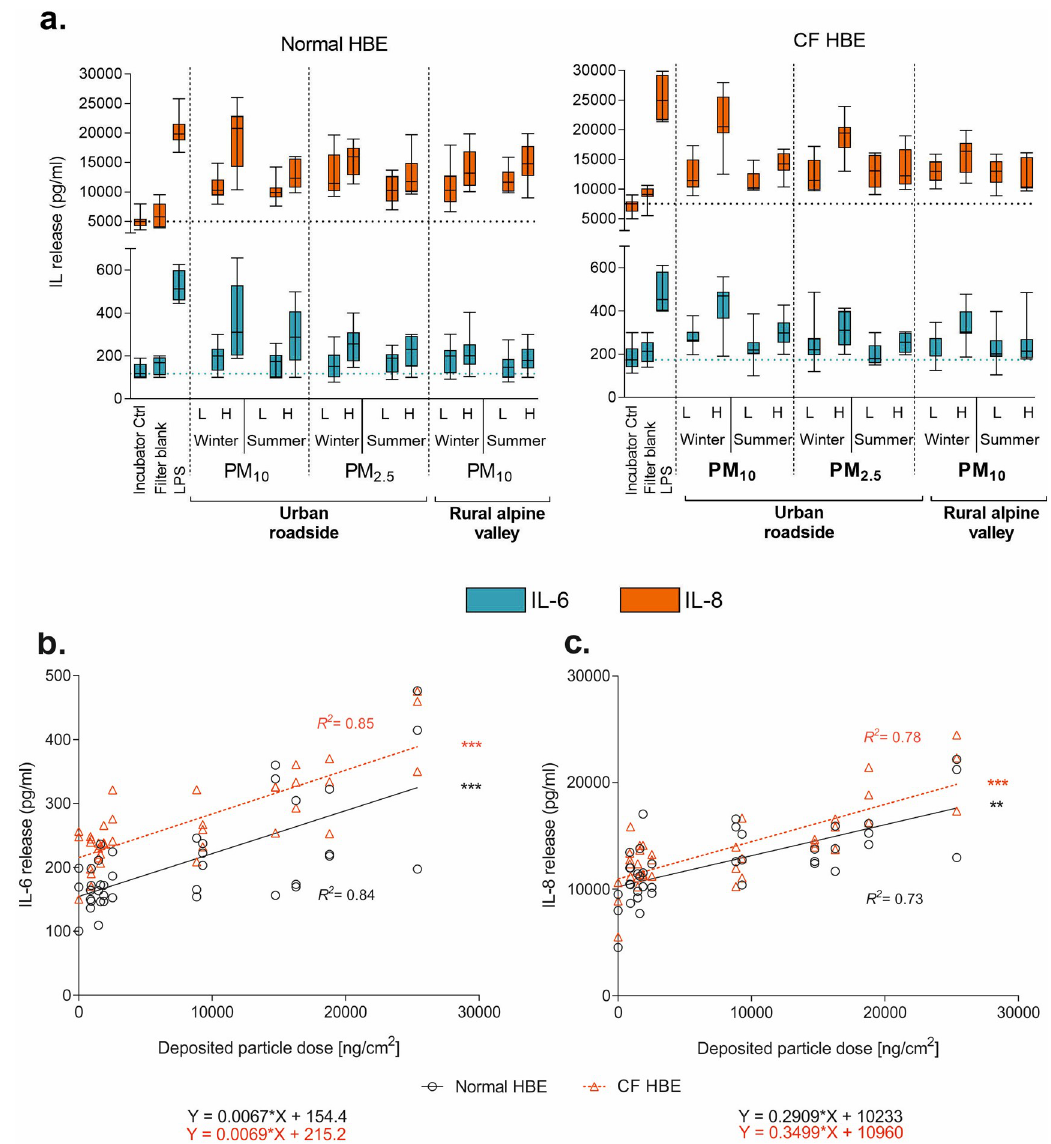
Fig 2. Inflammatory response of normal and cystic fibrosis (CF) human bronchial epithelia (HBE) 24 h after exposure to seasonally sampled PM from either an urban roadside (Bern) or a rural alpine valley site (Magadino). ( a ) Release of interleukin (IL)-6 and IL-8 into the basolateral compartment (dotted lines show interleukin release in incubator controls). The data are presented as mean values and error bars representing 1 standard deviation of three independent experiments (ANOVA, Dunnett’s multiple comparison) with triplicate cell cultures (total n = 9 cell cultures). ( b ) IL-6 and ( c ) IL-8 release vs. deposited particle dose associated with positive linear correlation using standard linear regression analysis. �� p-value < 0.01, ��� p-value < 0.001 compared to filter blank. Abbreviations: LPS = lipopolysaccharide (10 μ g/mL); L = low dose; H = high dose; R 2 = R-square linear coefficient of determination. in CF HBE, as compared to field blanks ( p-values < 0.0001), and IL-8 on average 2.2 fold in normal ( p-value = 0.0002) and 1.6 fold in CF HBE ( p-value < 0.0001) and irrespective of sea- sonal sampling. Although, the release of interleukins correlated well with the deposited dose in normal and CF HBE (R 2 = 0.84 and 0.85 for IL-6; R 2 = 0.73 and 0.78 for IL-8, Fig 2B–2C), there was no significant difference between PM and PM . Exposure to the positive-control 10 2.5